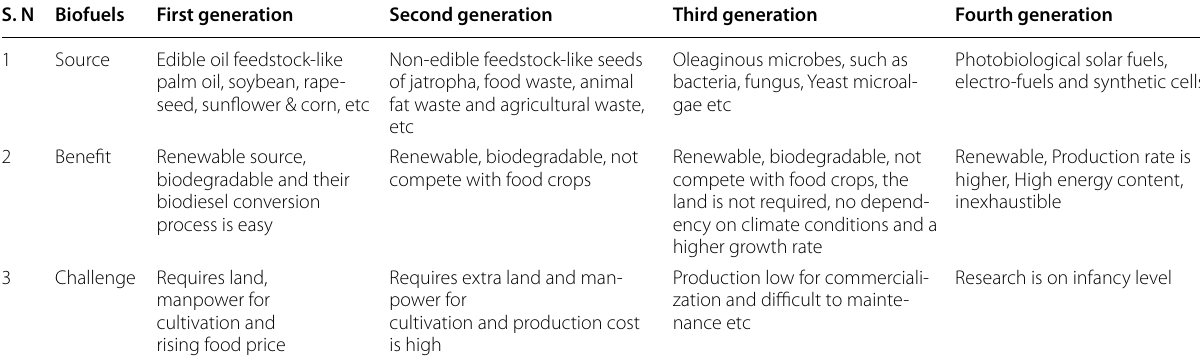
Table 1 Source, benefits and challenges of different generations biodiesel (Leong et al., 2018; Sigh et al.,